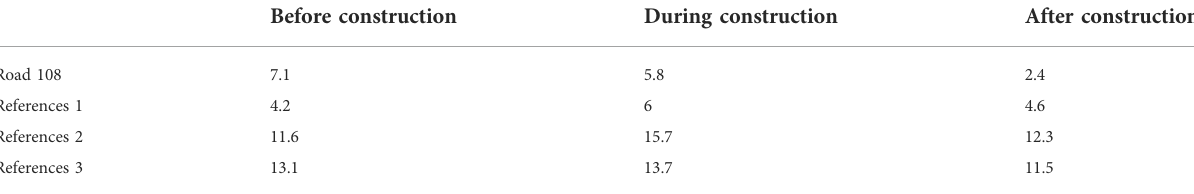
TABLE 3 Average number of WVC per annual quarter (i.e., Q1: January – March; Q2: April – June; Q3: July – September; Q4: October – December), before,duringandaftertheconstruction ofthefocalat-grade faunapassage.WVCaresummarizedforthefocal